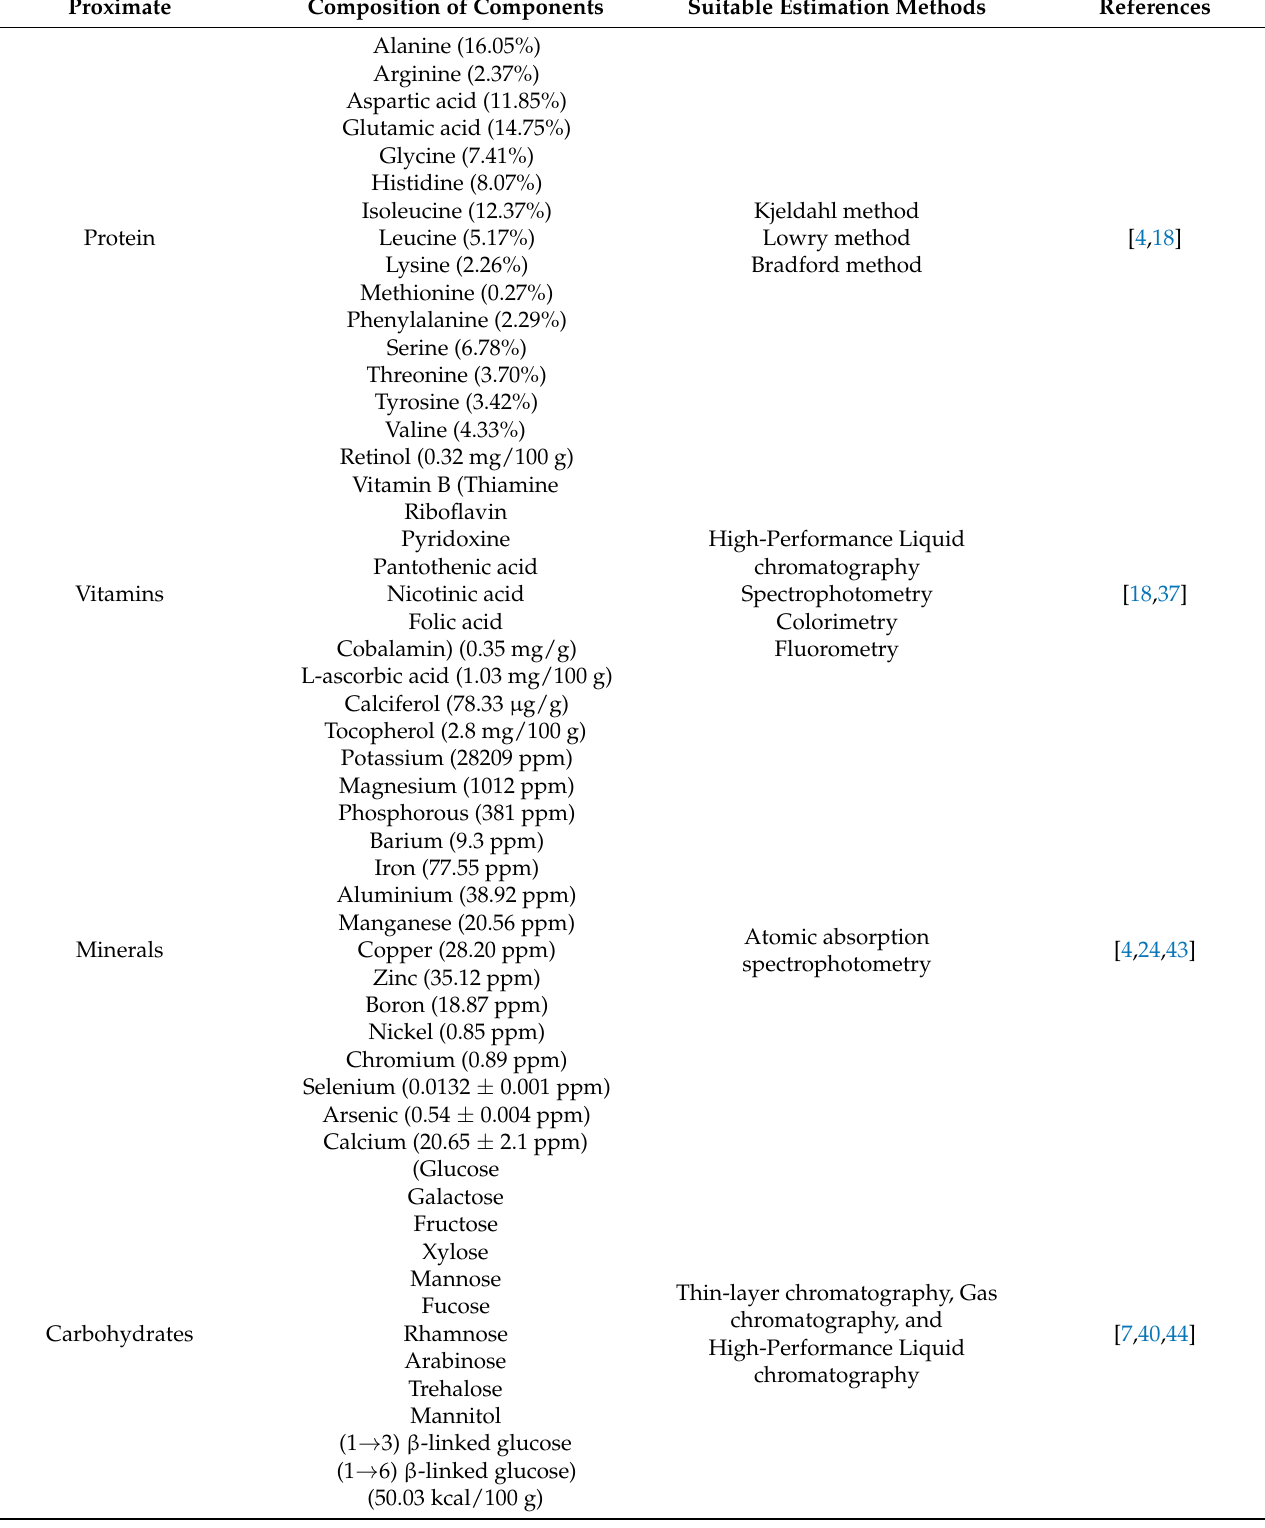
Table 1. Suitable methods for the estimation of the nutritional profile of Calocybe indica